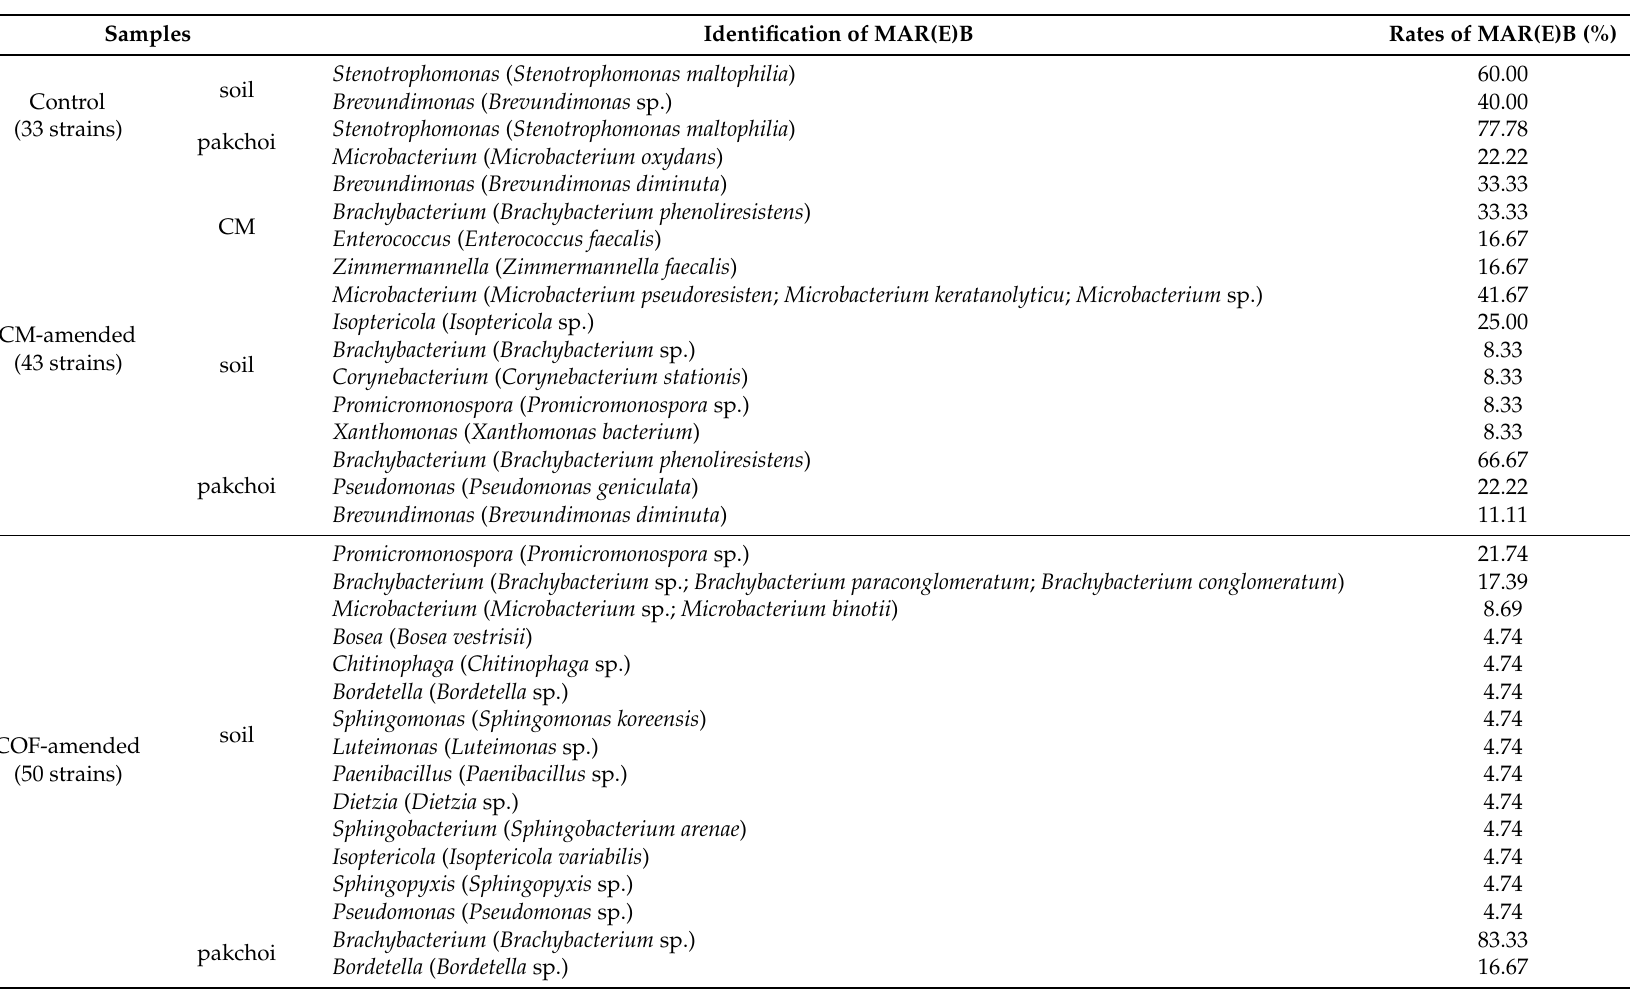
Table 3. Dominant genera of MARB and MAREB in CM- or COF-treated soil-pakchoi